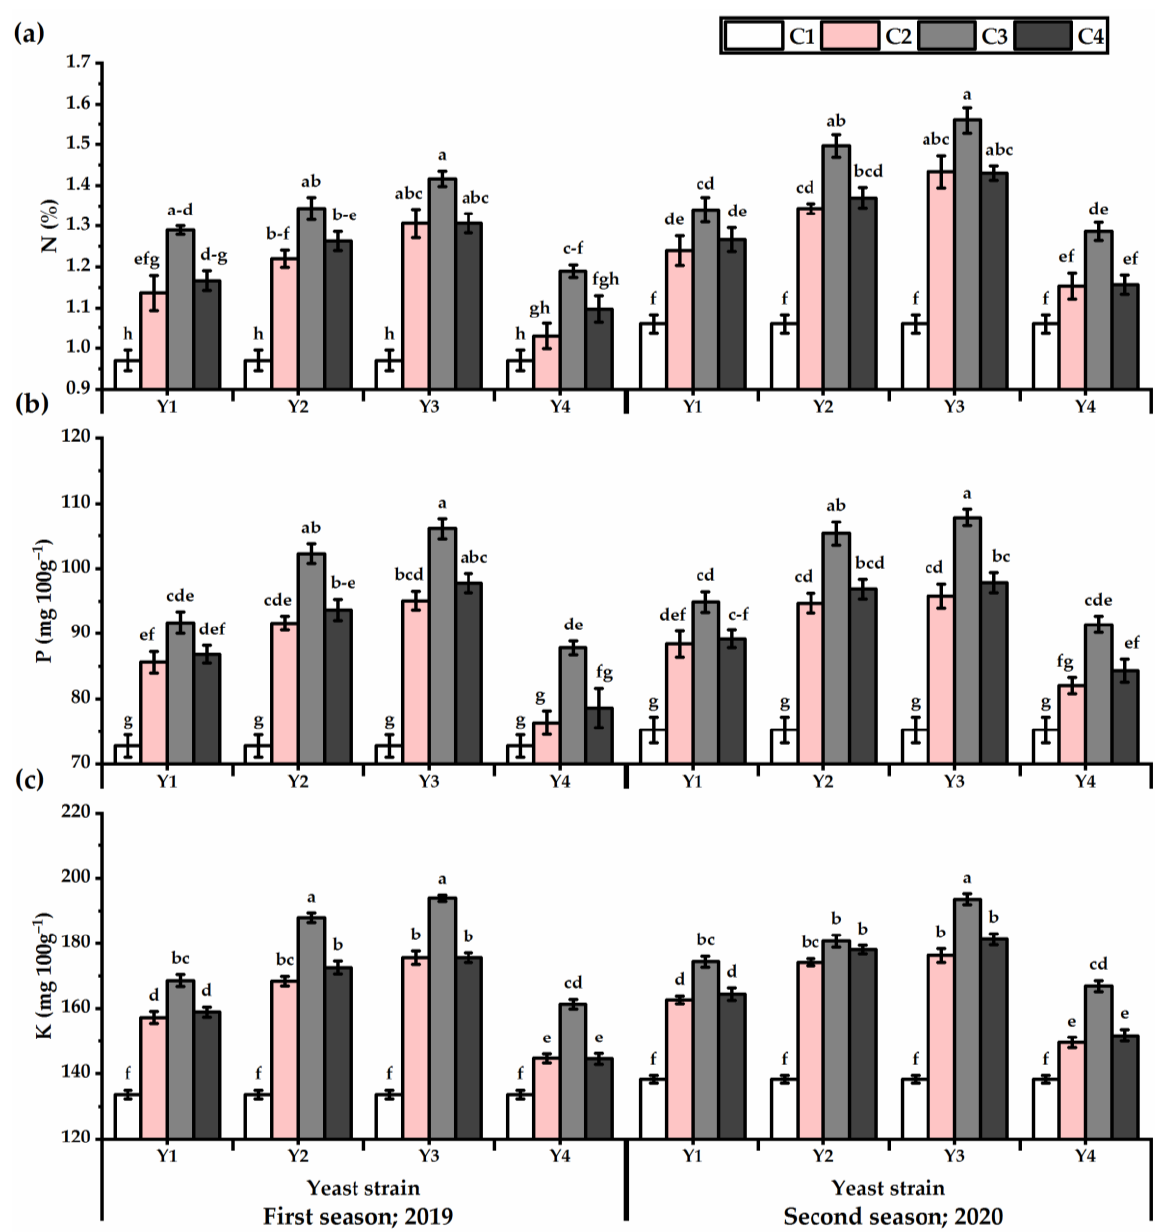
Figure 7. N (%) ( a ), P (mg 100 g − 1 ) ( b ), and K (mg 100 g − 1 ) ( c ) of Plectranthus amboinicus (Lour.) Spreng. plants subjected to Rhodotorula muciligenese (Y1), Candida sake (Y2), Candida apicola (Y3), and Candida kunwiensis (Y4) yeast strains foliar application at 0 (C1), 1 × 10 4 (C2), 1 × 10 7 (C3), and 1 × 10 9 (C4) CFU mL − 1 concentrations during 2019 and 2020 seasons. Data are mean value ± SE. Means with different letters for each season significantly differed, using Tukey’s test at p ≤ 0.05 level, n = 15.